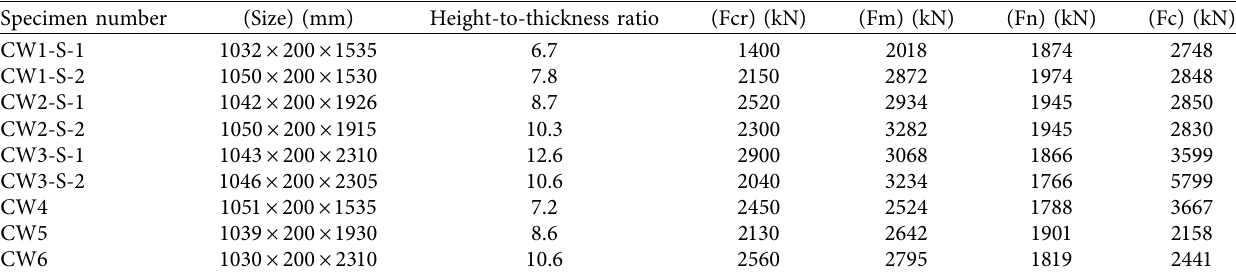
Table 2: Wall test results.